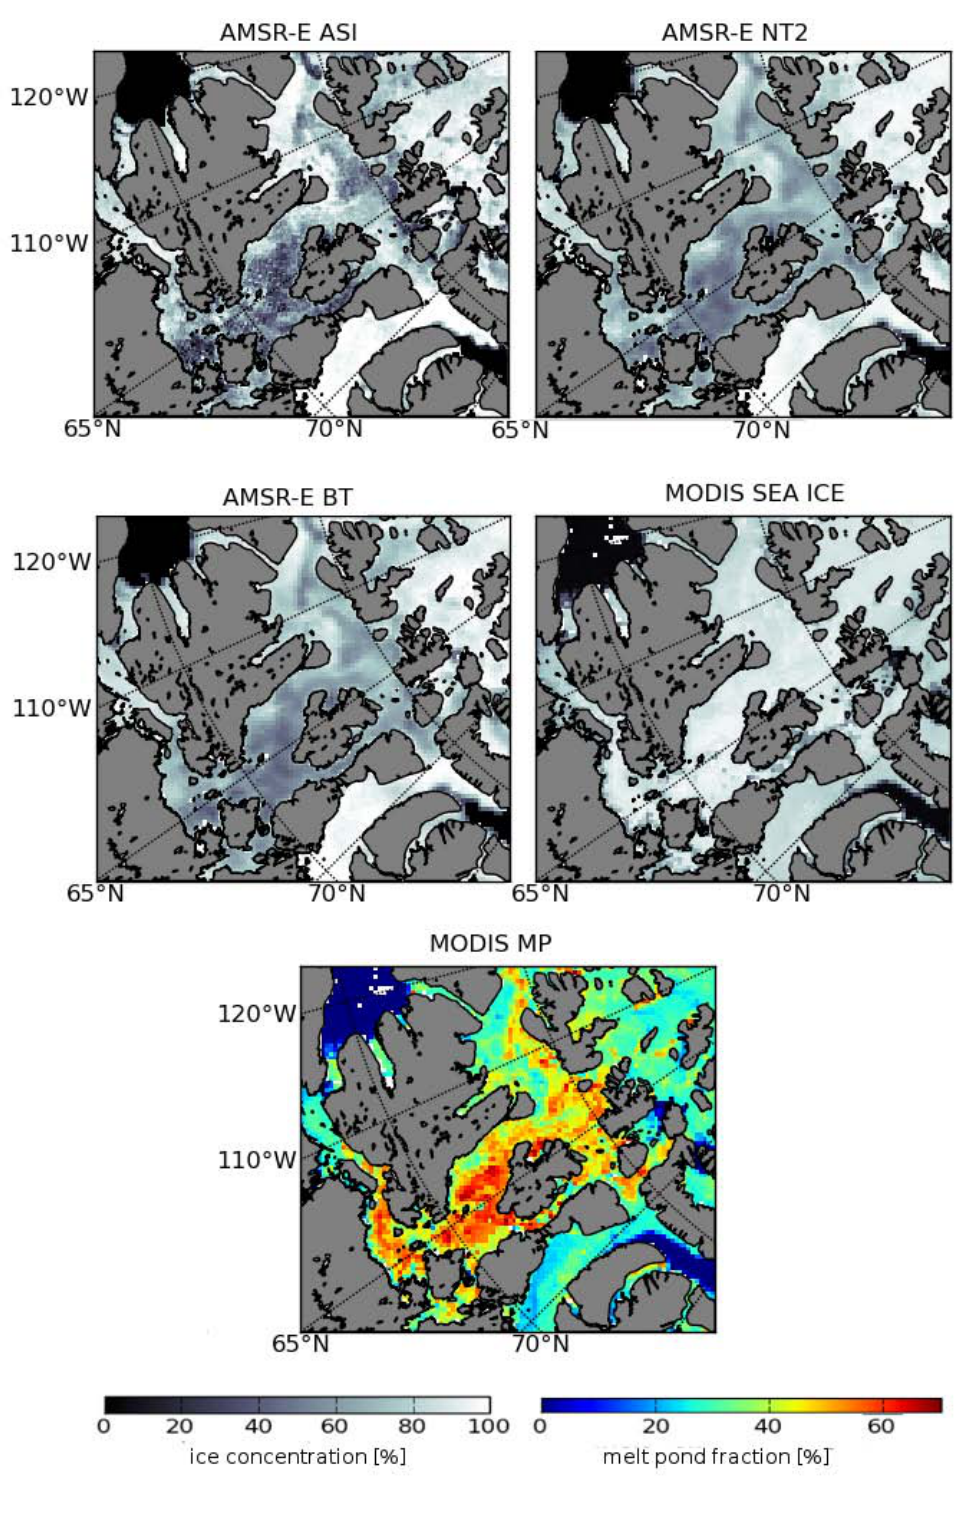
Fig. 8. Comparison of AMSR-E ASI (top left), AMSR-E NASA-Team 2 (top right), AMSR-E Bootstrap (middle left), and MODIS (middle right) sea ice concentrations. In the bottom MODIS relative melt pond fraction is displayed. All images are from 25 May 2008.